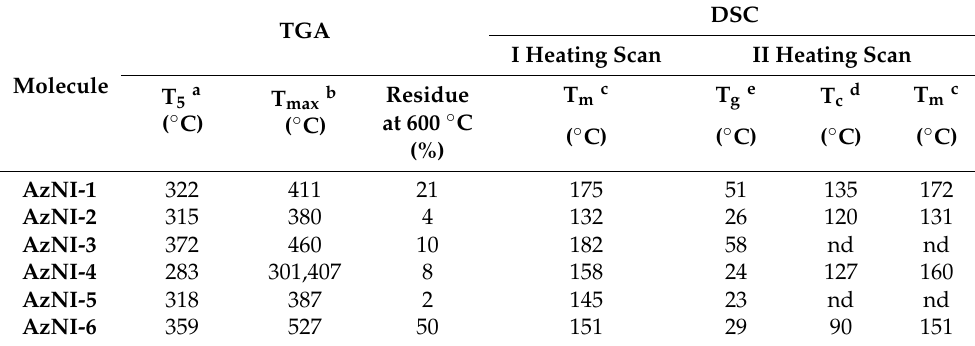
Figure 1. The synthetic route and chemical structure of N -hexyl-1,8-naphthalimide derivatives Insert: photos of the selected compounds under UV-light with λ ex = 366 nm. Table 1. TGA and DSC data of the investigated N -hexyl-1,8-naphthalimides